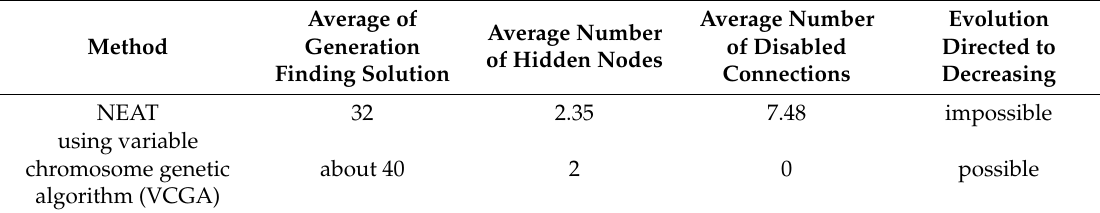
Table 1. Comparison with NeuroEvolution of Augmenting Topologies (NEAT) in exclusive or (XOR)